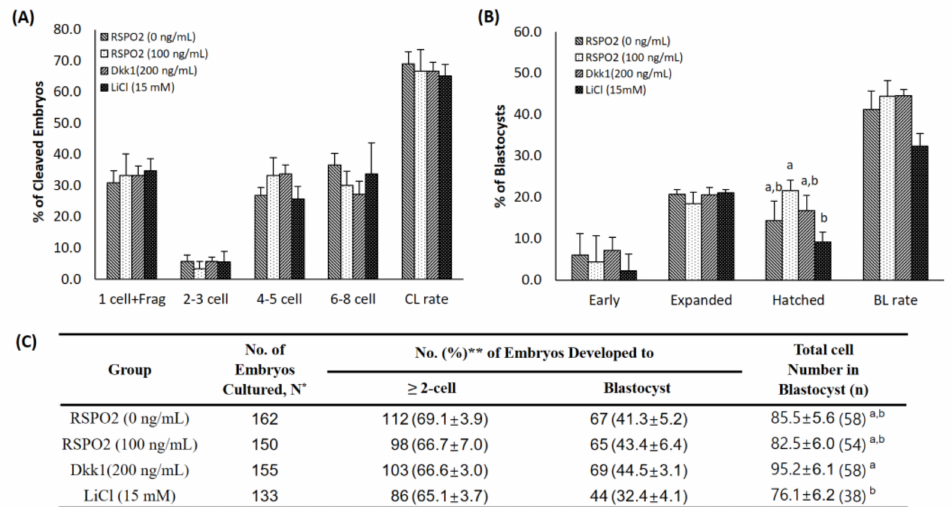
Figure 4. Effect of RSPO2, WNT inhibitor (Dkk1), or WNT activator (LiCl) treatment during IVM on embryonic development after in vitro fertilization (IVF) in terms of the ( A ) cleavage pattern and ( B ) blastocyst formation pattern of the IVF embryo. Within each end point, bars with different letters (a and b) are significantly ( p < 0.05) different. CL, cleavage; BL, blastocyst. ( C ) Summary of embryonic development after IVF. The cleavage rate was measured on day 2, and the blastocyst formation rate was evaluated on day 7 of culture. * N: Four replications. RSPO2: R-Spondin2. ** Percentage of total embryos